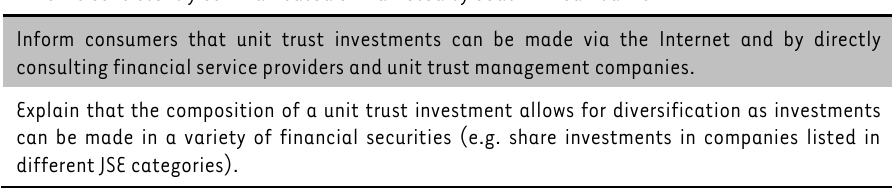
TABLE 9: Strategies to ensure consumers’ accessibility to unit trusts and related information Ensure that unit trust investment information is as available to consumers as banking information, which is consistently communicated or marketed by South African